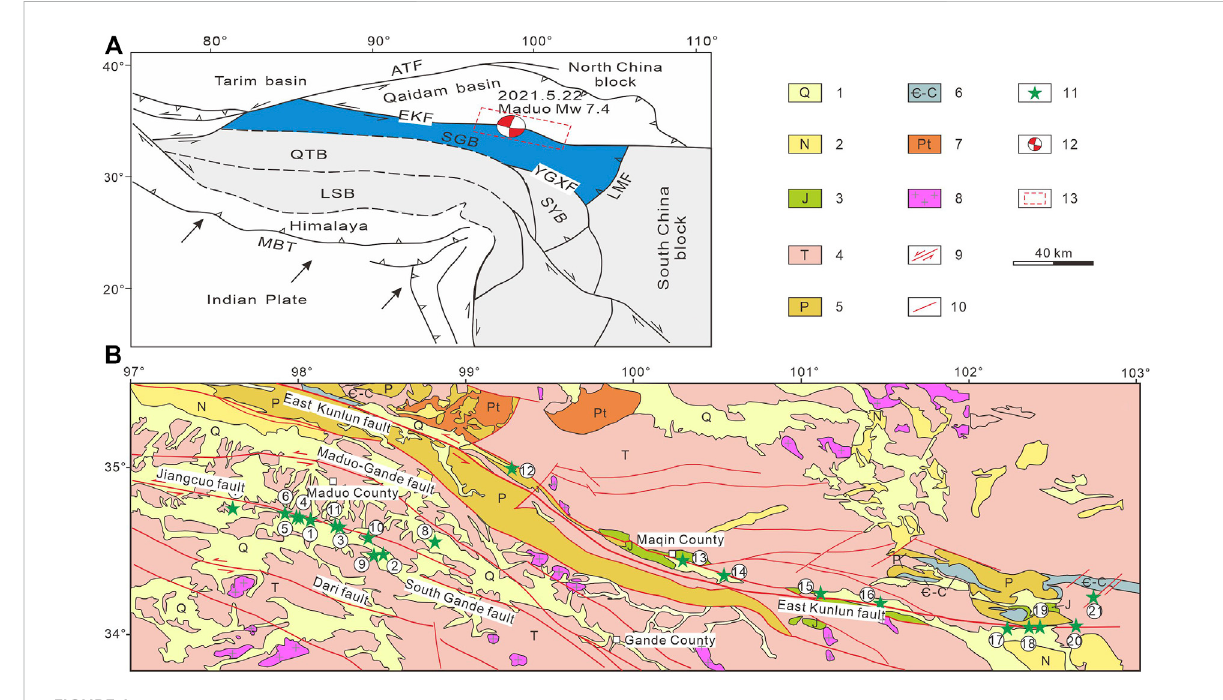
FIGURE 1 Simpli fi ed geological map showing tectonic features and sample distribution in the study area (modi fi ed from Wu et al., 2016). (A) Geological units and tectonic boundaries of the Tibetan Plateau and adjacent regions. Abbreviations: LSB, Lhasa block; QTB, Qiangtang block; SGB, Songpan- Ganzi block; SYB, Sichuan-Yunnan block; Tarim basin; Qaidam basin; ATF, Altyn Tagh fault; EKF, East Kunlun fault; LMF, Longmenshan fault; YGXF, Yushu-Ganzi-Xianshuihe fault; MBT, Main Boundary Thrust. (B) Regional geological information and sample distribution in the Maduo surface rupture zone and theEast Kunlun fault zone. Numbers1 – 21 in circles represent serial numbers of sampling sites(see Table 1).Legends are shown by